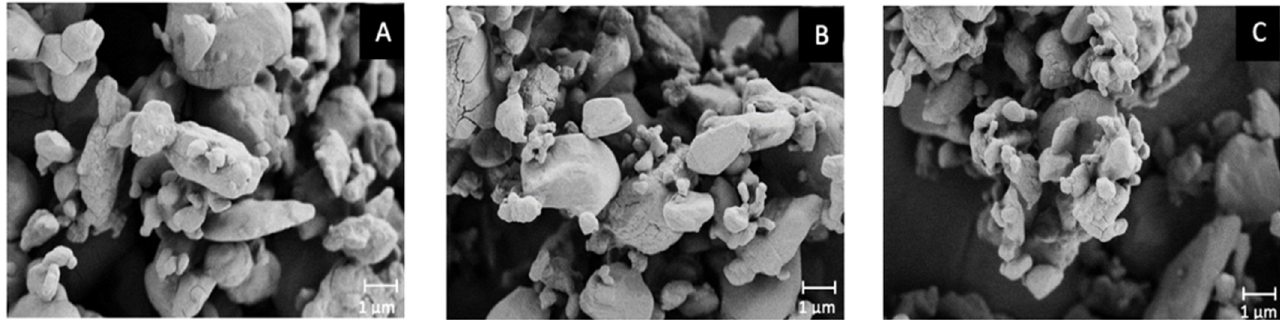
Figure 6. Scanning electron microscopy images of tiotropium test blend formulations: ( A ) Tbr batch #A; ( B ) Tbr batch #B; ( C ) Tbr batch #C (magnification × 20K).